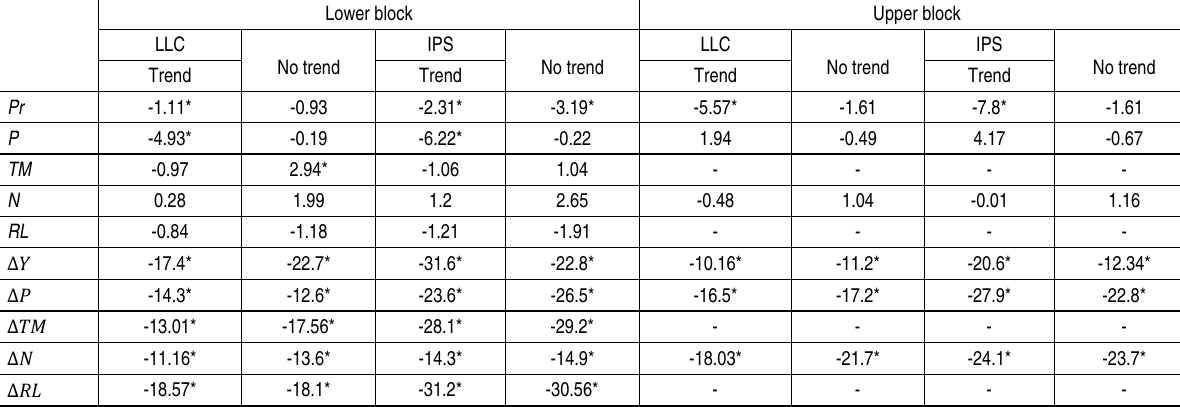
Table 3. First generation panel unit roots